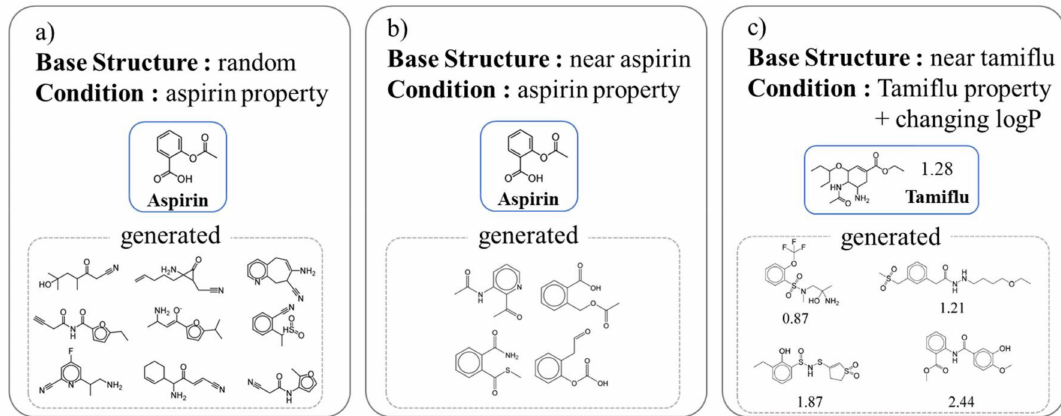
Figure 5. Generated compounds from conditional VAE. ( a ) Compounds created by adding aspirin condition to random points (compound structure) in the latent space. Although the form is different, they have similar properties (MW, logP, HBD, HBA, and TPSA). ( b ) Compounds produced by controlling the properties of aspirin at random points close to aspirin in the latent space. It looks very similar to aspirin. ( c ) Compounds produced by changing log P while maintaining the structure and other properties of Tamiflu. Only the desired properties in the reference compound can be controlled and improved. This figure is modified from